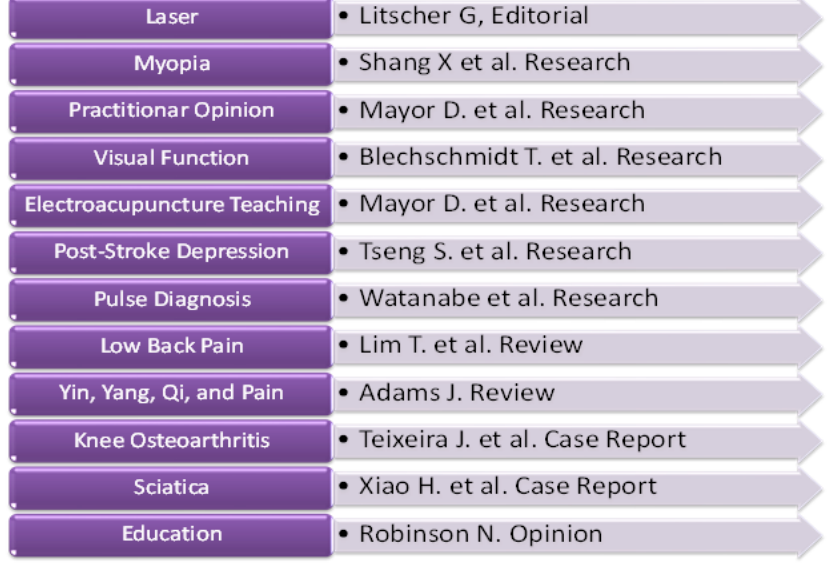
Figure 1. Topics of the present Medicines special issue.